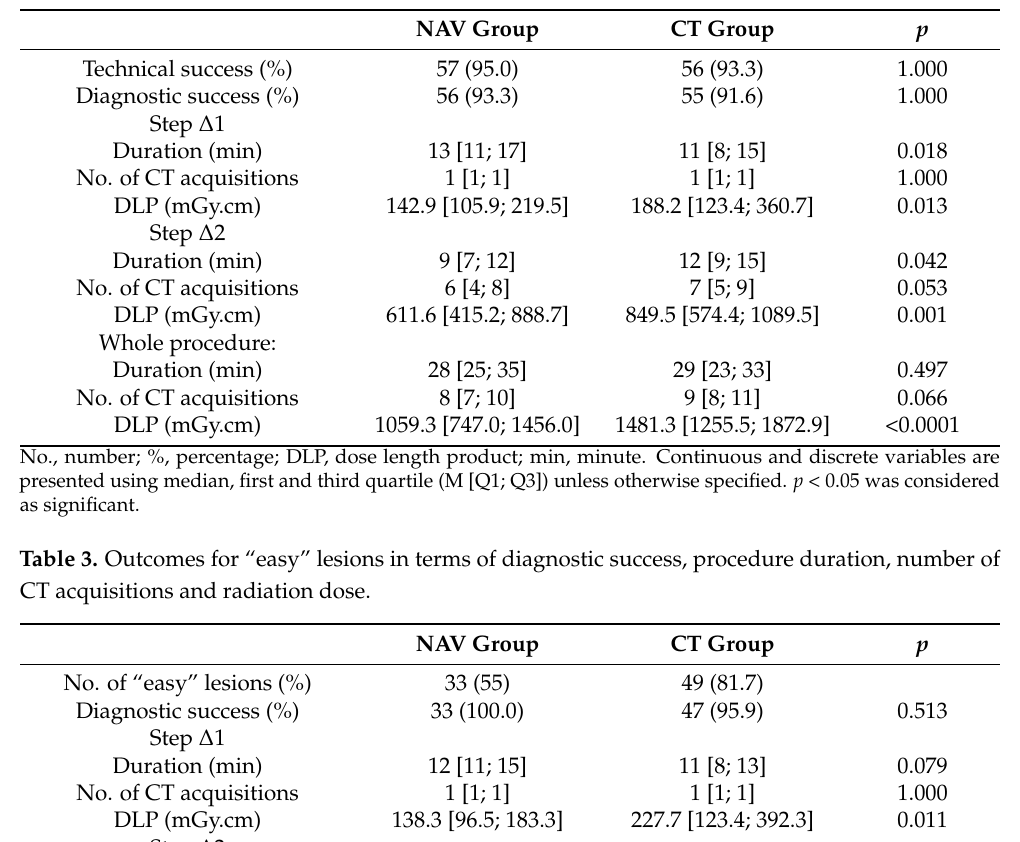
Table 2. Technical and diagnostic success, procedure duration, number of CT acquisitions and radiation dose.